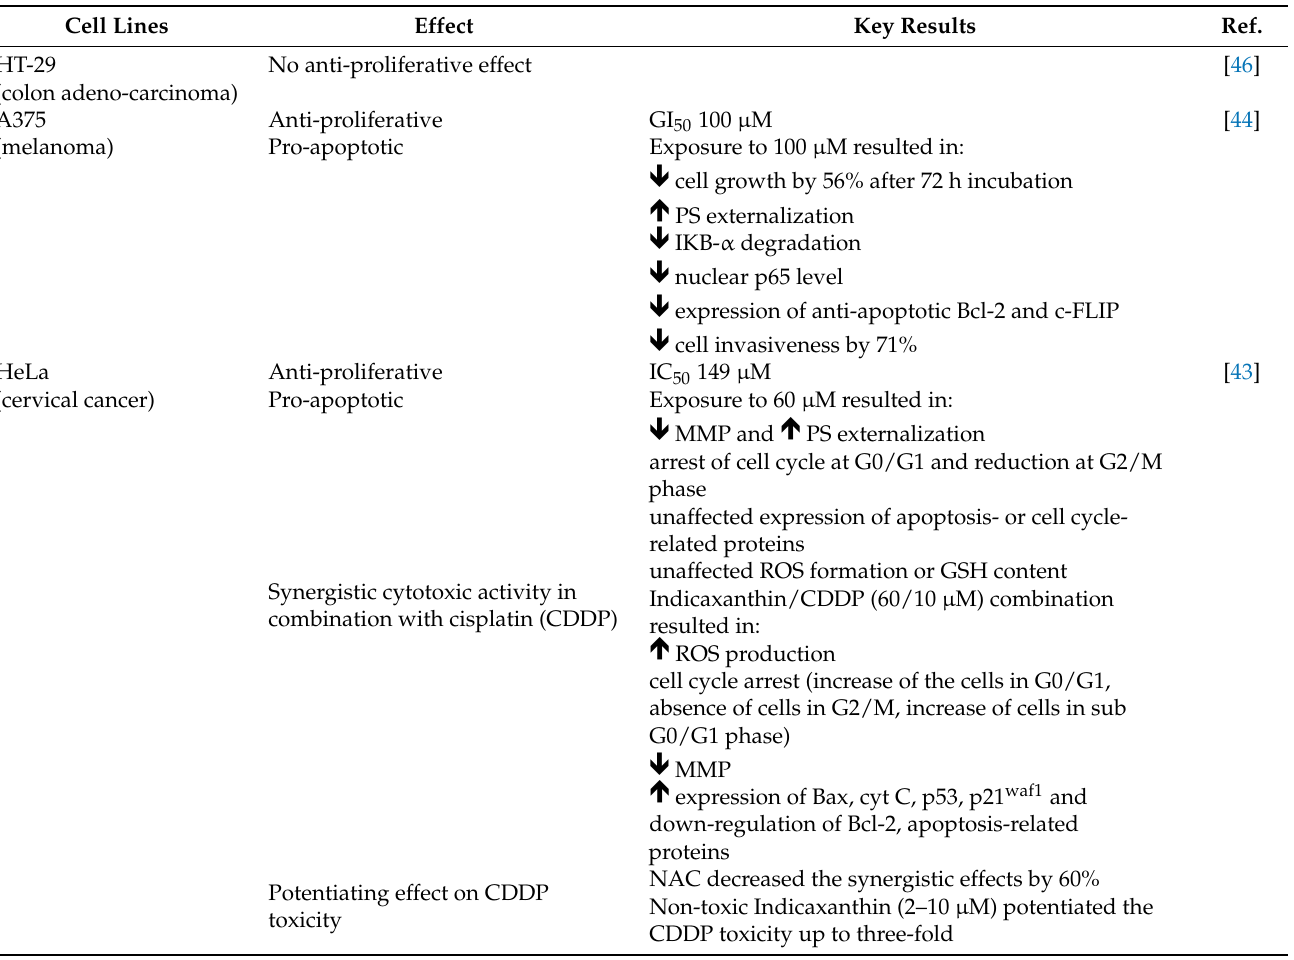
Table 5. Activity of Indicaxanthin in C. elegans. Table 4. Cont.